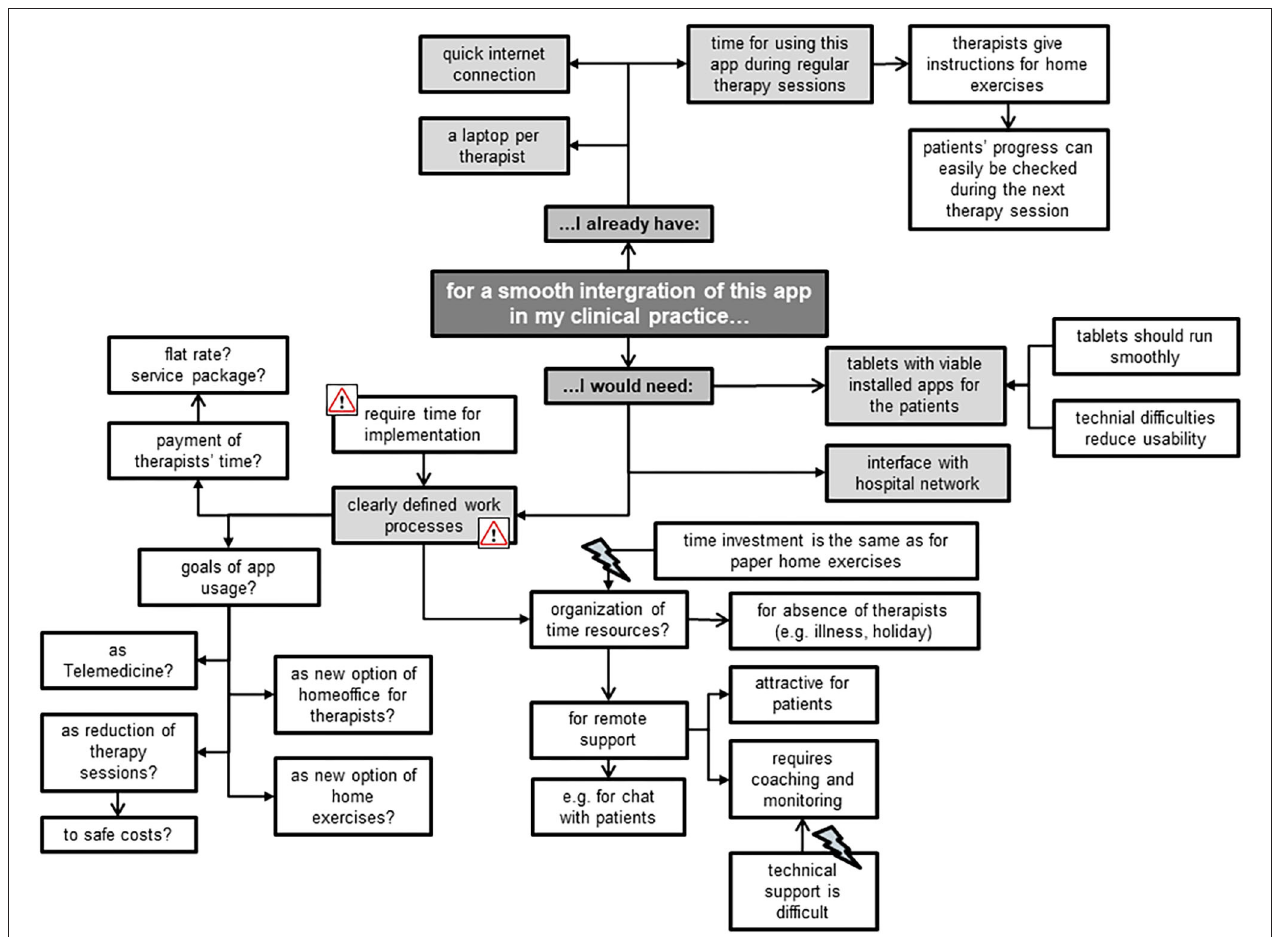
FIGURE 7 | Workplace requirements for a smooth integration of the Fit app in clinical